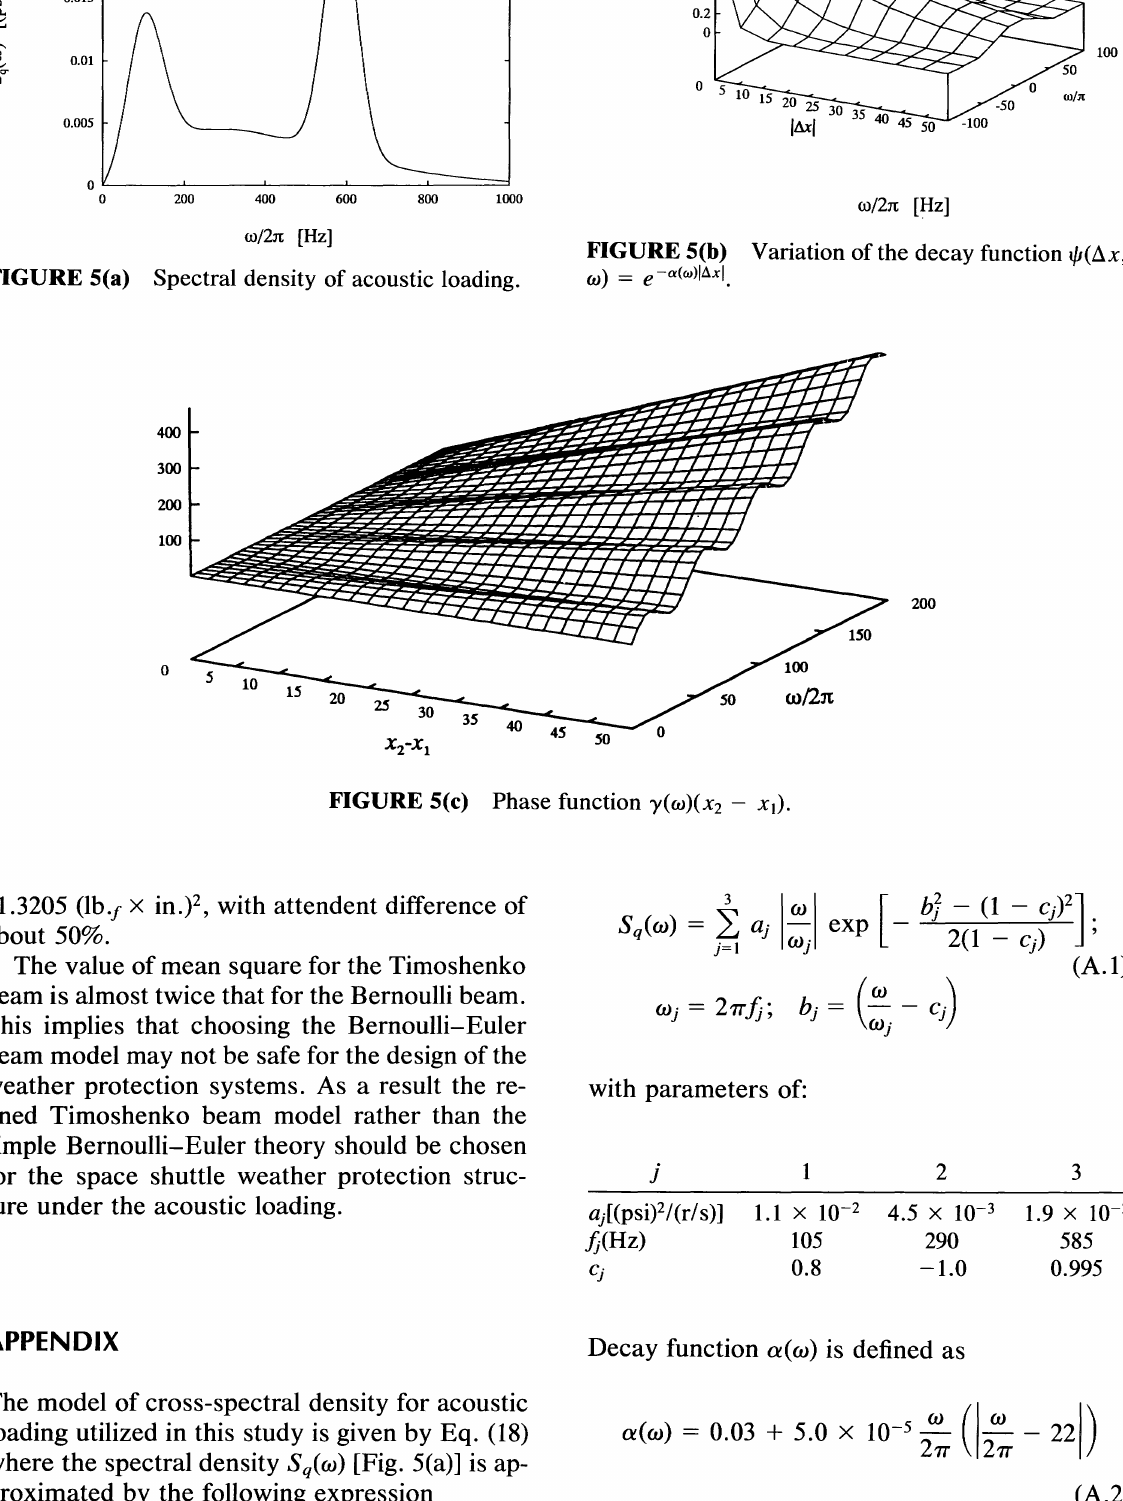
FIGURE 5(b) Variation of the decay function I/J(th, w) = e -u(wlIAxl.